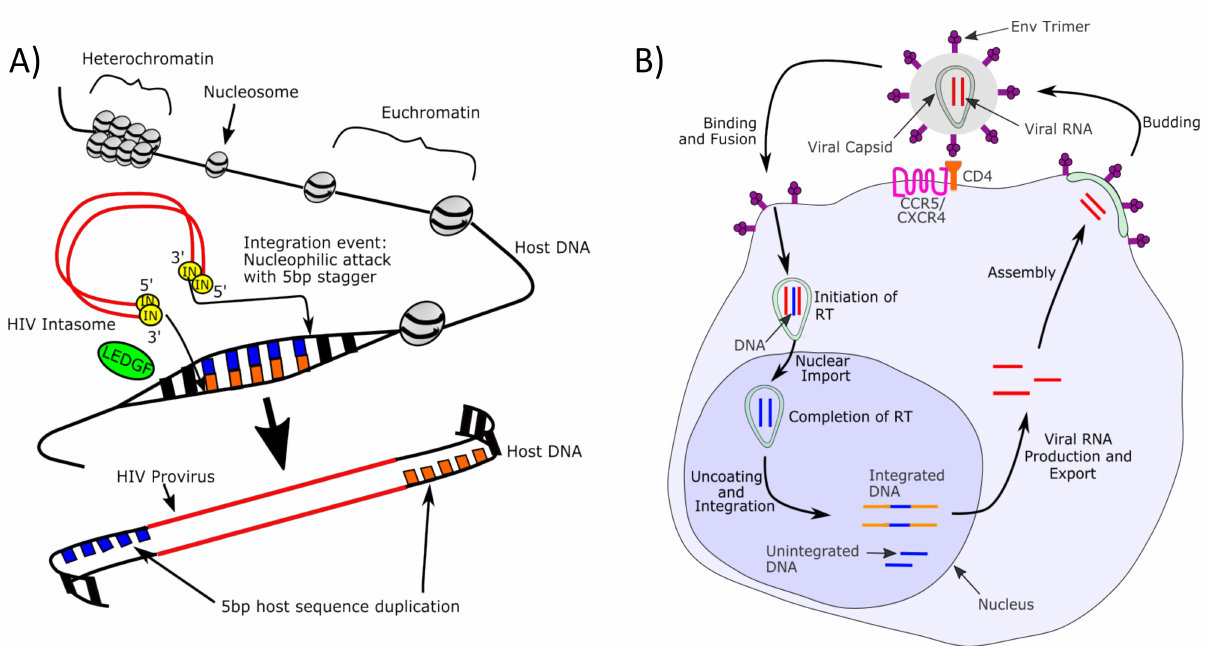
Figure 1. ( A ) Mechanism of HIV integration. HIV proviruses integrate into host DNA via a nucleophilic attack, staggered by 5 host base pairs. This staggering of base pairs allows for integration site analysis to determine true clonal expansion from the results of polymerase chain reaction (PCR) amplification. HIV integration favors transcriptionally active regions of the chromosome and, therefore, typically does not take place within tightly bound heterochromatin. LEDGF/p75 is a transcriptional activator that guides integration towards transcriptionally active regions and AT-rich regions. A simplified representation of the HIV intasome is depicted. It is likely comprised of a multimer of integrase molecules. Bp: base pair; IN: integrase tetramer. Adapted from [64]. ( B ) Phases of the productive HIV replication cycle. HIV proviruses also replicate through clonal expansion, not depicted here. RT: reverse